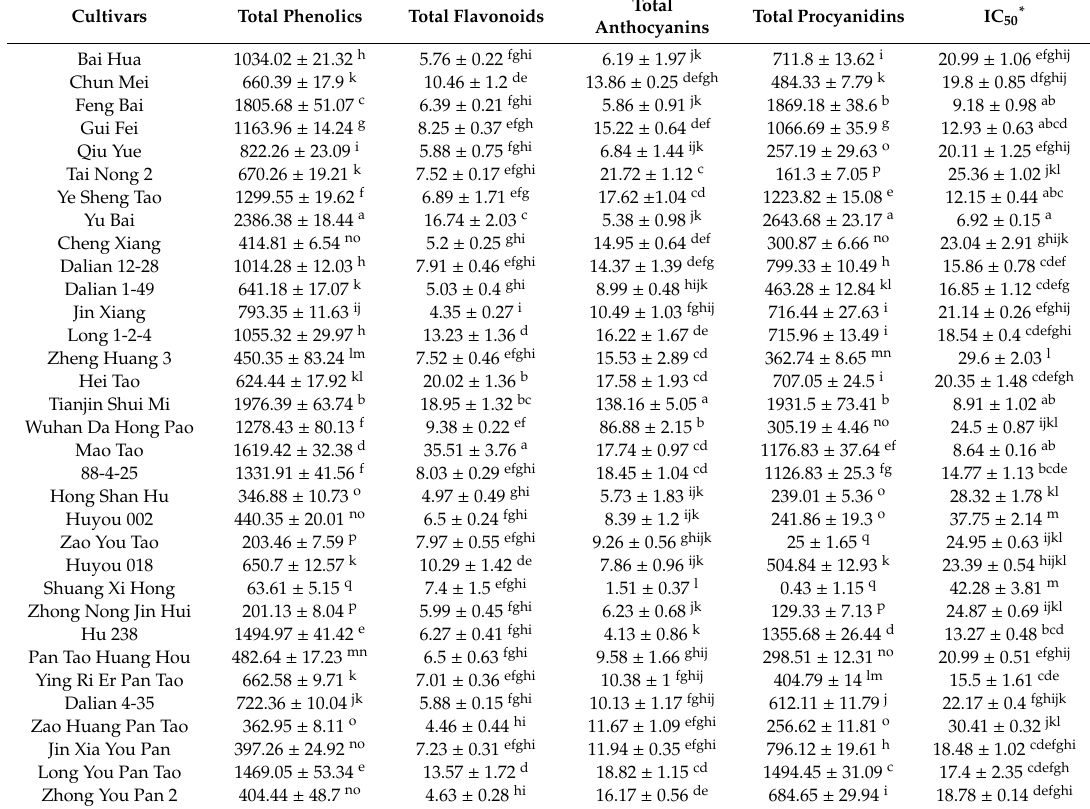
Table 1. Total phenolics, total flavonoids, total anthocyanins, and total procyanidins contents, and alpha-glucosidase inhibitory activity in the pulp extract of 33 peach cultivars from